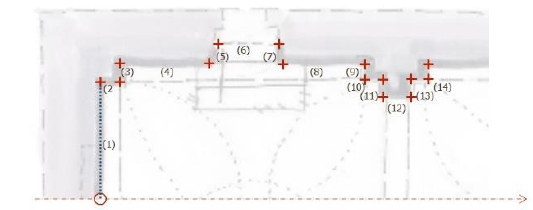
Figure 12 : Control points between segments forming a contour .